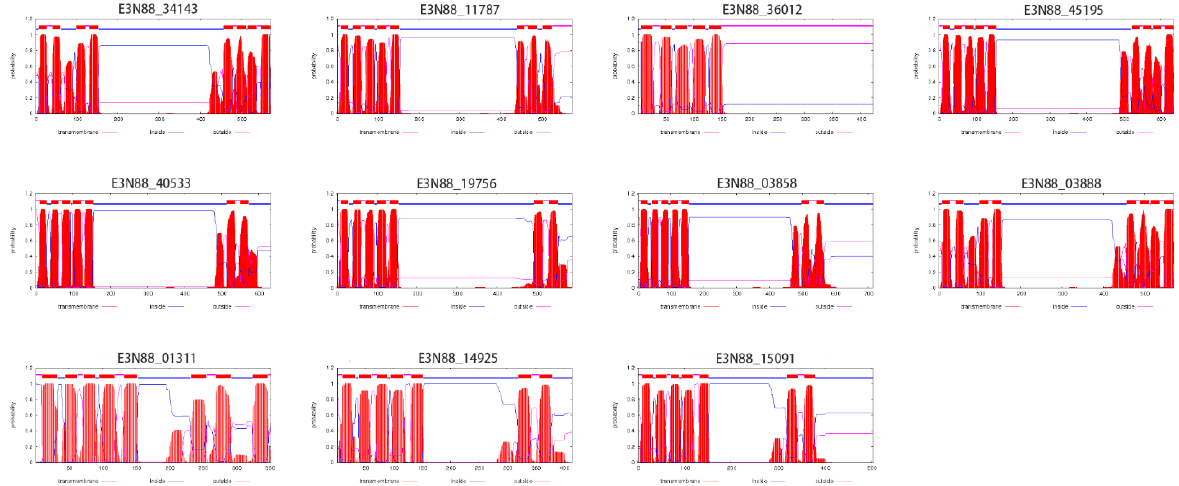
Figure 4. Transmembrane analysis of PIN proteins in M. micrantha . The red peaks represent the predicted transmembrane domain and blue color line indicate the central hydrophobic loop of proteins.